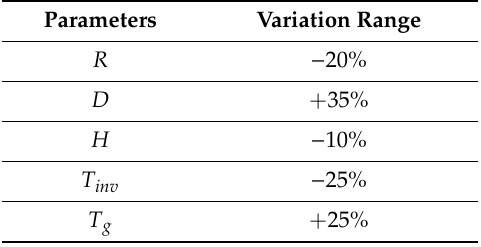
Table 2. Uncertain parameters of the test MG.